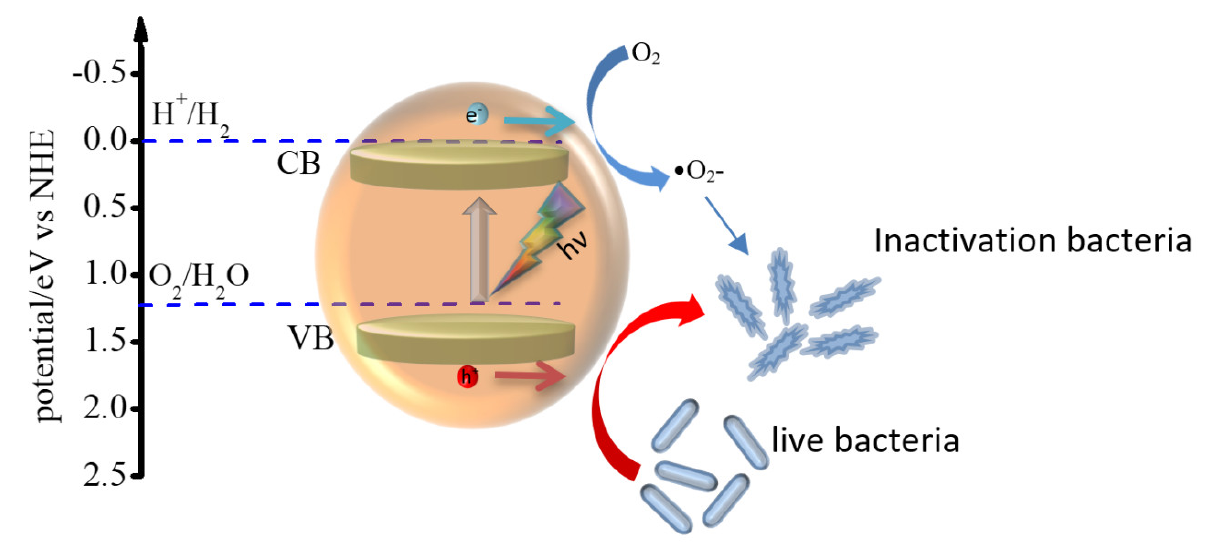
Figure 5. Charge carrier trapping experiment, AgNO 3 as electron scavenger and methanol as hole scavenger of Ag 9 (SiO 4 ) 2 NO 3 .